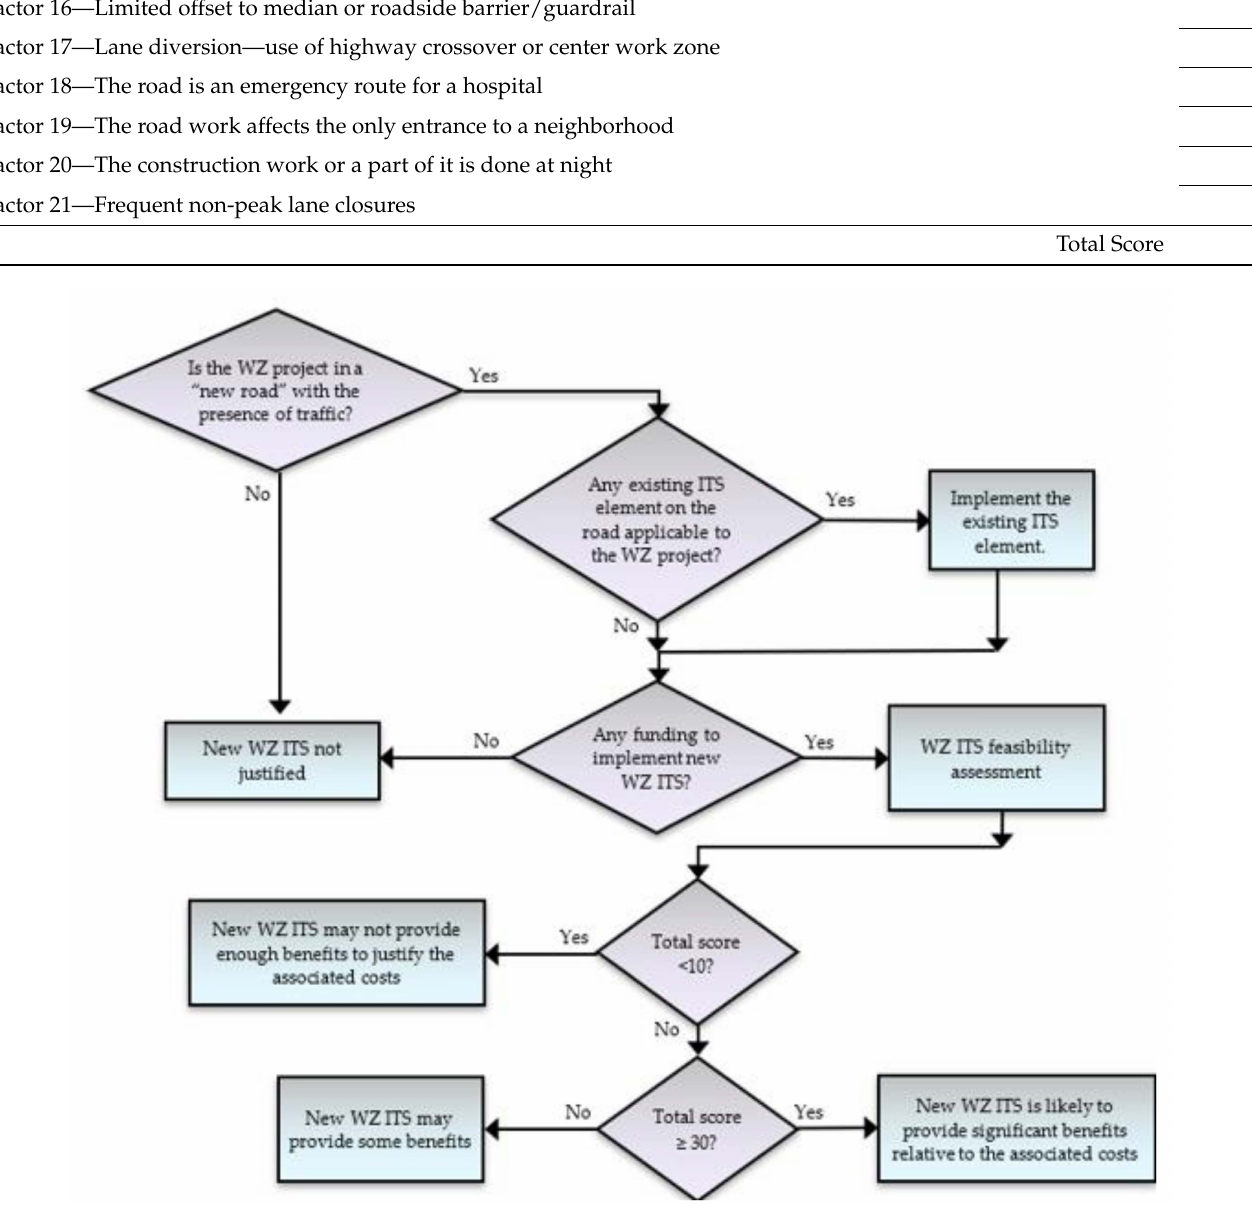
Figure 1. Flowchart used to assess the feasibility of a work zone